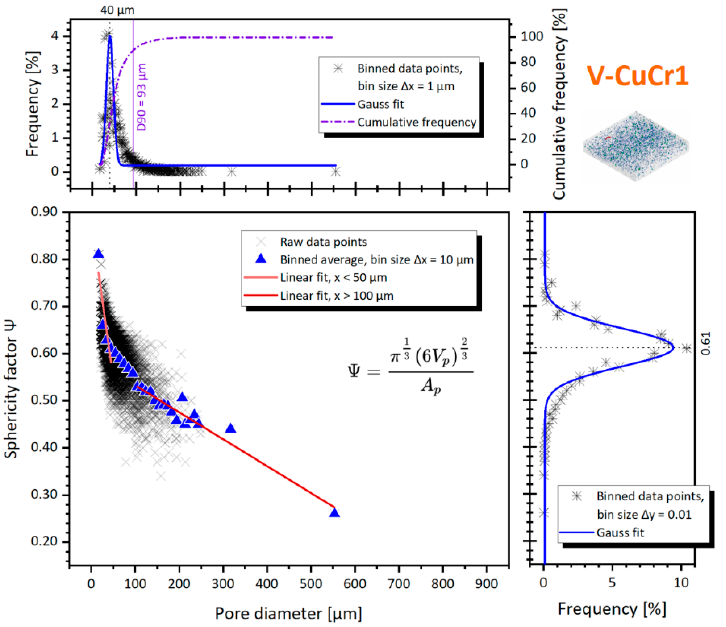
Figure 6. Pore diameter against the sphericity factor for the V-CuCr1 sample; inserts with percentage frequency distributions of both sphericity and diameter are included.